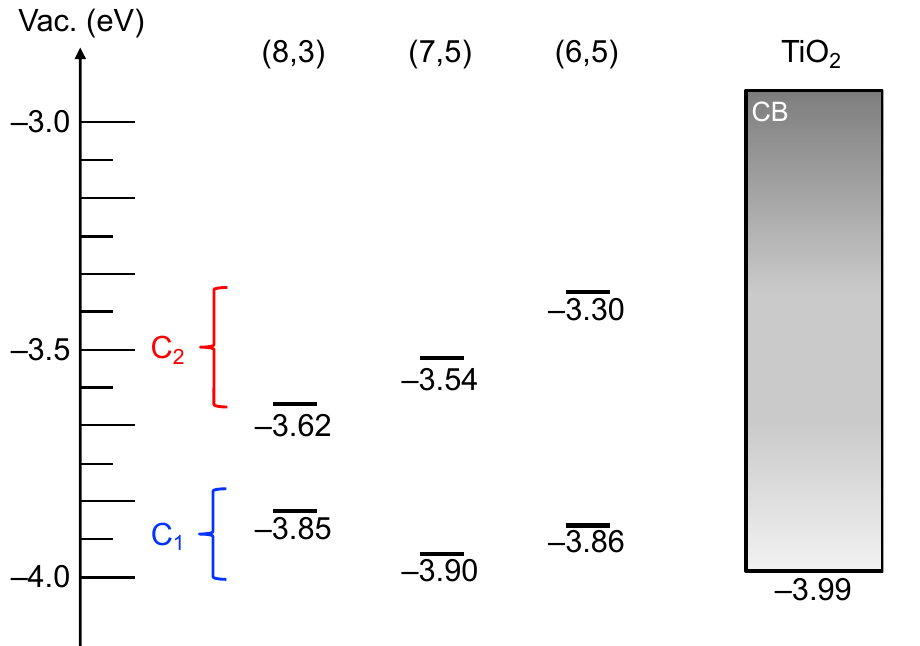
Figure 9. Energy level diagram of SWCNT/TiO 2 heterojunctions. Gray bar reveals the conduction band of TiO 2 .